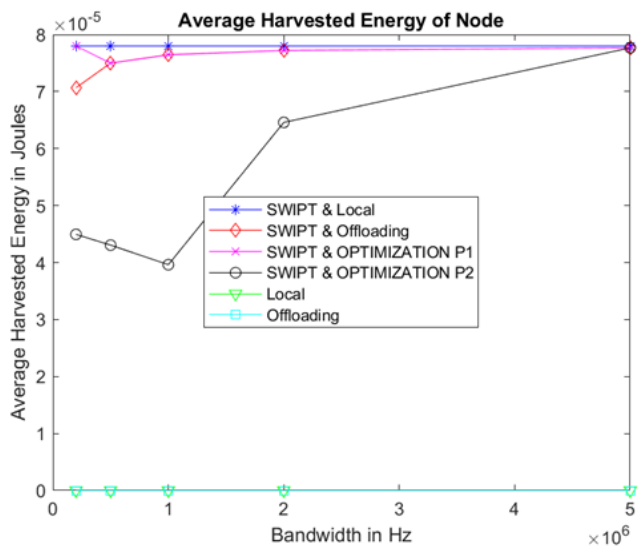
Figure 8. Average harvested energy of the end